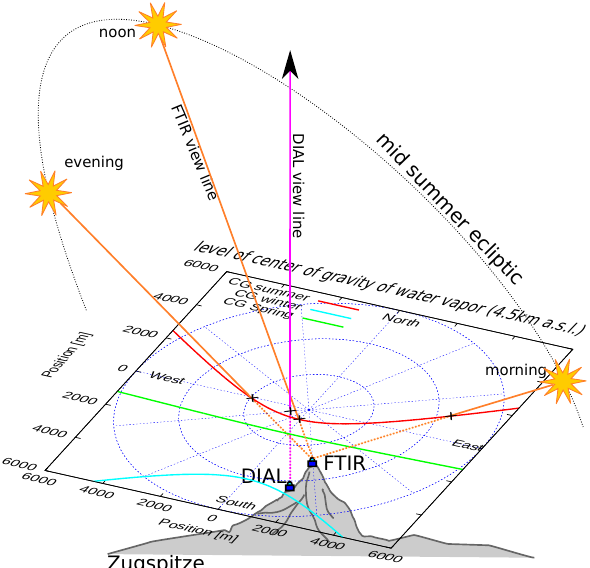
Figure 1. Geometrical setup of the IWV intercomparison between DIAL and FTIR on the Zugspitze. The DIAL is located 680m to the southwest of the FTIR and 288m below. The horizontal coordinate grid plane marks the mean altitude of the center of gravity of the water vapor distribution above the Zugspitze (see text) and its point of origin is vertical above the FTIR. The red, green, and blue curves in the CG plane are the trajectories of the points, where the view line (e.g., orange lines from FTIR to the sun in the case of midsummer) of the FTIR meets the CG plane in midsummer, spring, and mid- winter. Consequently, the trajectories mark the horizontal position of the center of gravity of the water vapor distribution measured by the FTIR along its slanted view line. The pink line marks the fixed vertical view line of the